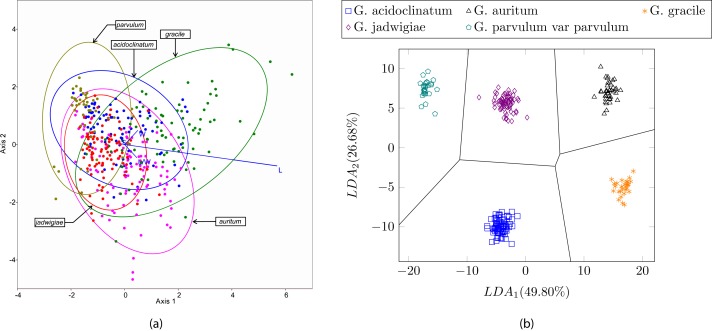
(A) Canonical variates analysis (CVA) biplot obtained in Blanco, Borrego-Ramos & Olenici (2017). Dots represents individuals and lines predictors. (B) Cluster representation for the first two components of the resulting feature vector after dimensionality reduction corresponding to the dataset presented in Table 3.For visualization purposes centroids of the clusters were calculated with K-medoids.